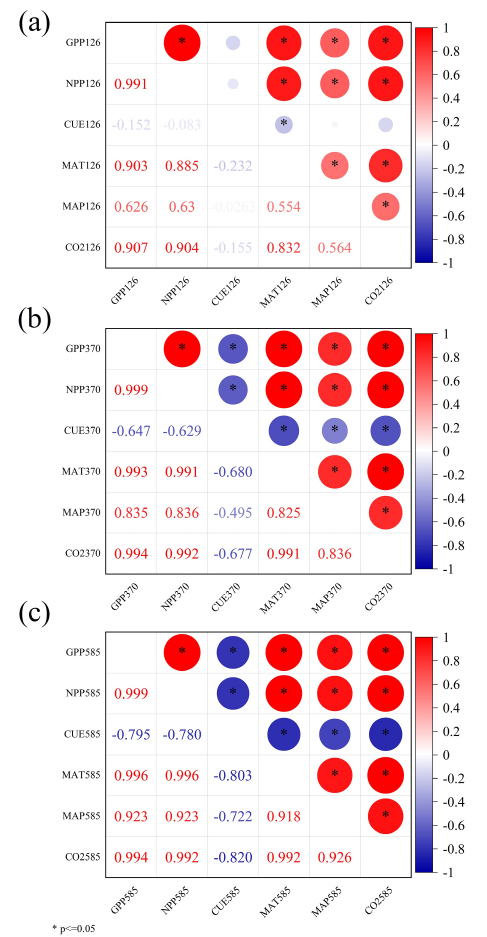
Figure 3. Correlations among GPP, NPP, CUE, MAT, MAP, and CO 2 concentration in the three scenarios. Correlations under the SSP1-2.6 scenario are shown in ( a ). Correlations under the SSP3-7.0 scenario are shown in ( b ). Correlations under the SSP5-8.5 scenario are shown in ( c ). The size of the circle and the depth of the color indicate the level of correlation; red indicates a positive correlation, and blue indicates a negative correlation. * means the correlation is likely not =